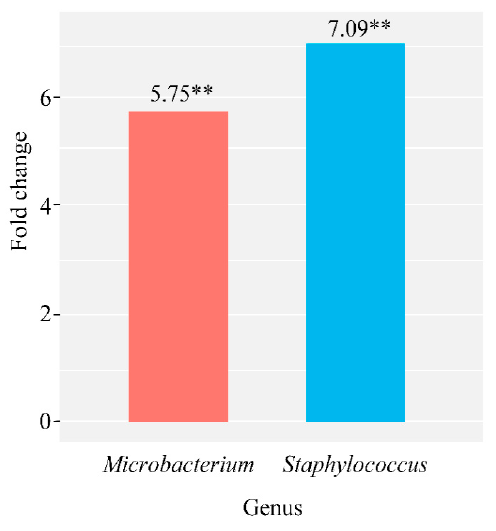
Figure 3. Quantitative changes in the general microbiome composition of milk samples taken from cows with udder irritation compared to the control group ( ∗∗ p ≤ 0.001).